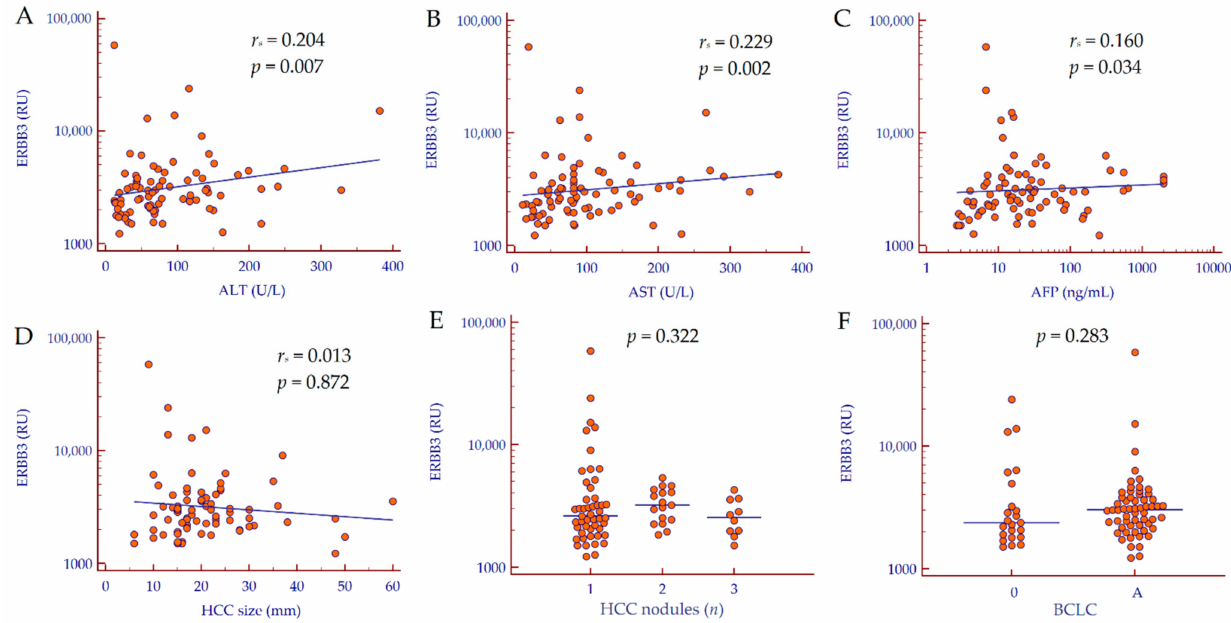
Figure 2. Correlation analysis. ( A – D ) Correlation between continuous variables was assessed by Spearman’s rank correlation coefficient. ( E ) p value was calculated by the Kruskal–Wallis test. ( F ) p value was calculated by the Mann–Whitney test. Abbreviations: alpha-fetoprotein (AFP), alanine aminotransferase (ALT), aspartate aminotransferase (AST), Barcelona Clinic Liver Cancer (BCLC), epidermal growth factor receptor 3 (ERBB3), hepatocellular carcinoma (HCC), number ( n ), arbitrary REAAD™ Units